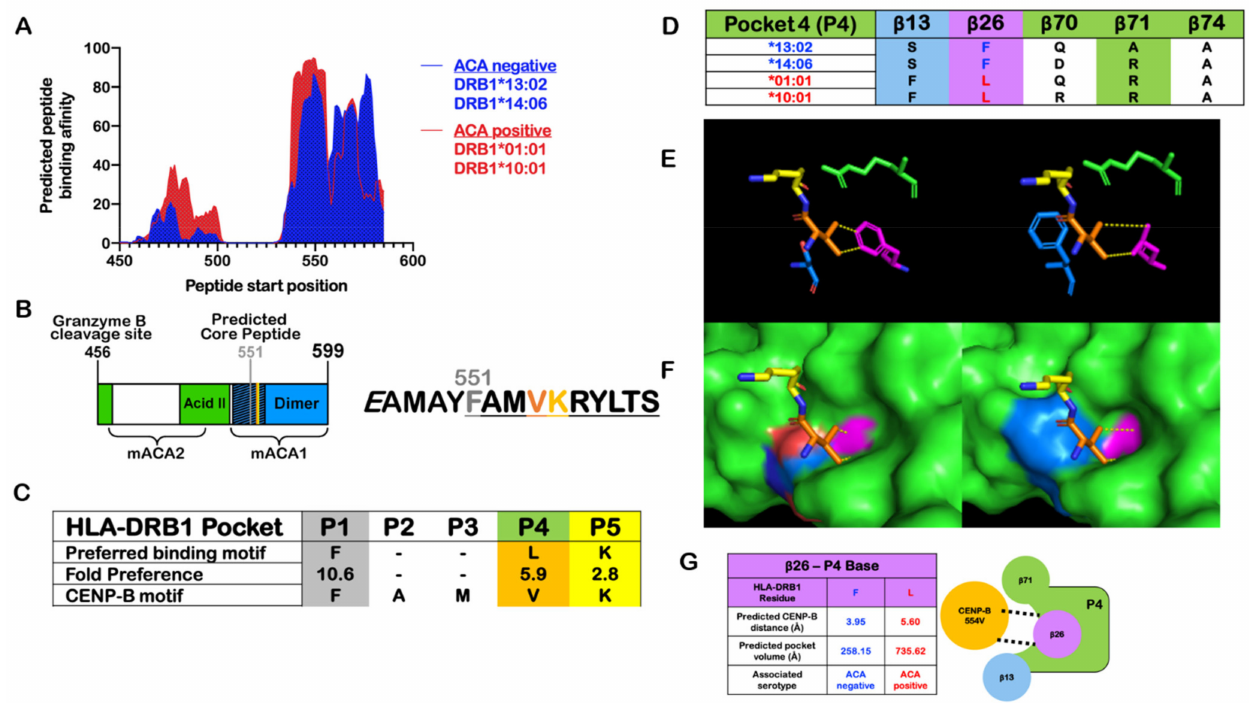
Figure 3. Specificity of CENP-B cleavage correlates with ACA epitope preservation. ( A ) The protein sequence border between acidic region II and the dimerization domain contains peptide sequences with the highest predicted binding affinity in selected MHC class II (HLA–DRB1) alleles. Plotted as binding affinity percentiles, higher percentile = stronger binding, blue curve = alleles associated with the ACA-negative serotype, and red = ACA-positive serotype. A broader peak around position 550, with higher percentile binding, is present in ACA-positive alleles, consistent with a predisposition to ACA serotype development via MHC class II presentation. ( B ) Left: schematic of the CENP-B C-terminal 143 aa, corresponding to the fragment produced by granzyme B cleavage. The predicted core peptide region (from Figure 3A) lies within the mACA1 epitope, the major epitope target of ACAs. Right: predicted CENP-B core peptide sequence. Color coding of residues corresponds with ( C ). ( C ) Comparison between the preferred HLA–DRB1 peptide-binding motif and the predicted CENP-B core peptide. Pockets are formed by the HLA–DRB1 β chain amino acid sequence and are variable in composition between alleles. ( D ) HLA β chain sequence differences in alleles associated with ACA serotypes. β Chain residues forming pocket 4. β 13 S and β 26 F are independently associated with the ACA-negative serotype. β 26 L has been proposed as a requirement for the ACA-positive serotype. Blue = ACA-negative alleles; red = ACA-positive alleles, same as ( A ). ( E ) Ball-and-stick model of predicted CENP-B core peptide and HLA–DRB1 pocket 4 residues. Left: β 13 serine, β 26 phenylalanine. Right: β 13 phenylalanine, β 26 leucine. For all: blue = β 13, purple = β 26, green = β 71, orange = CENP-B 554 valine, and yellow = CENP-B 555 lysine. ( F ) Surface model of predicted CENP-B core peptide and HLA-DRB1 pocket 4 residues, same as ( E ). Note the increased pocket depth on the right, corresponding to ACA- positive alleles as in ( D ). ( G ) Predicted effect of HLA–DRB1 β 26 on CENP-B core peptide stability. Left: estimated distance between HLA β 26 and CENP-B 554 valine side chain carbons as in ( E ). Volume calculated from distance. Right: schematic of HLA–DRB1 pocket 4 and predicted CENP-B core peptide